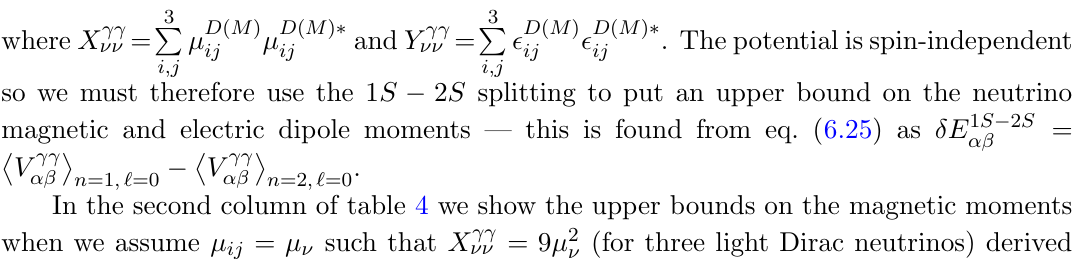
Table 4 . Upper limits on the magnetic moment (cid:22) (cid:23) in units of the Bohr magneton probed by the dipole-dipole potential V (cid:13)(cid:13) ( r ), derived from the 1 S (cid:0) 2 S splittings of the systems ( f (cid:11) ; f (cid:12) ). (cid:11)(cid:12) Equivalent limits apply for the electric dipole moment (cid:15) (cid:23) . We assume three light active neutrinos with m 1 = 0 : 1 eV and NO masses and mixings. For Dirac neutrinos we take (cid:22) ij (cid:17) (cid:22) (cid:23) , (cid:15) ij (cid:17) (cid:15) (cid:23) , while for Majorana neutrinos (cid:22) ij (cid:17) (cid:22) (cid:23) (1 (cid:0) (cid:14) ij ), (cid:15) ij (cid:17) (cid:15) (cid:23) (1 (cid:0) (cid:14) ij ). We also derive upper limits on the heavy sterile neutrino magnetic moments (cid:22) ij = (cid:22) N (1 (cid:0) (cid:14) ij ) for i; j = 4 ; 5, i.e. introducing two heavy Majorana neutrinos in the type-I seesaw. Active neutrino magnetic moments (cid:22) (cid:23) / " 2 and active-sterile transition magnetic moments (cid:22) (cid:23)N / " are